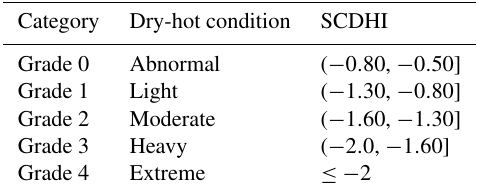
Table 1. Categories of compound dry and hot conditions based on the